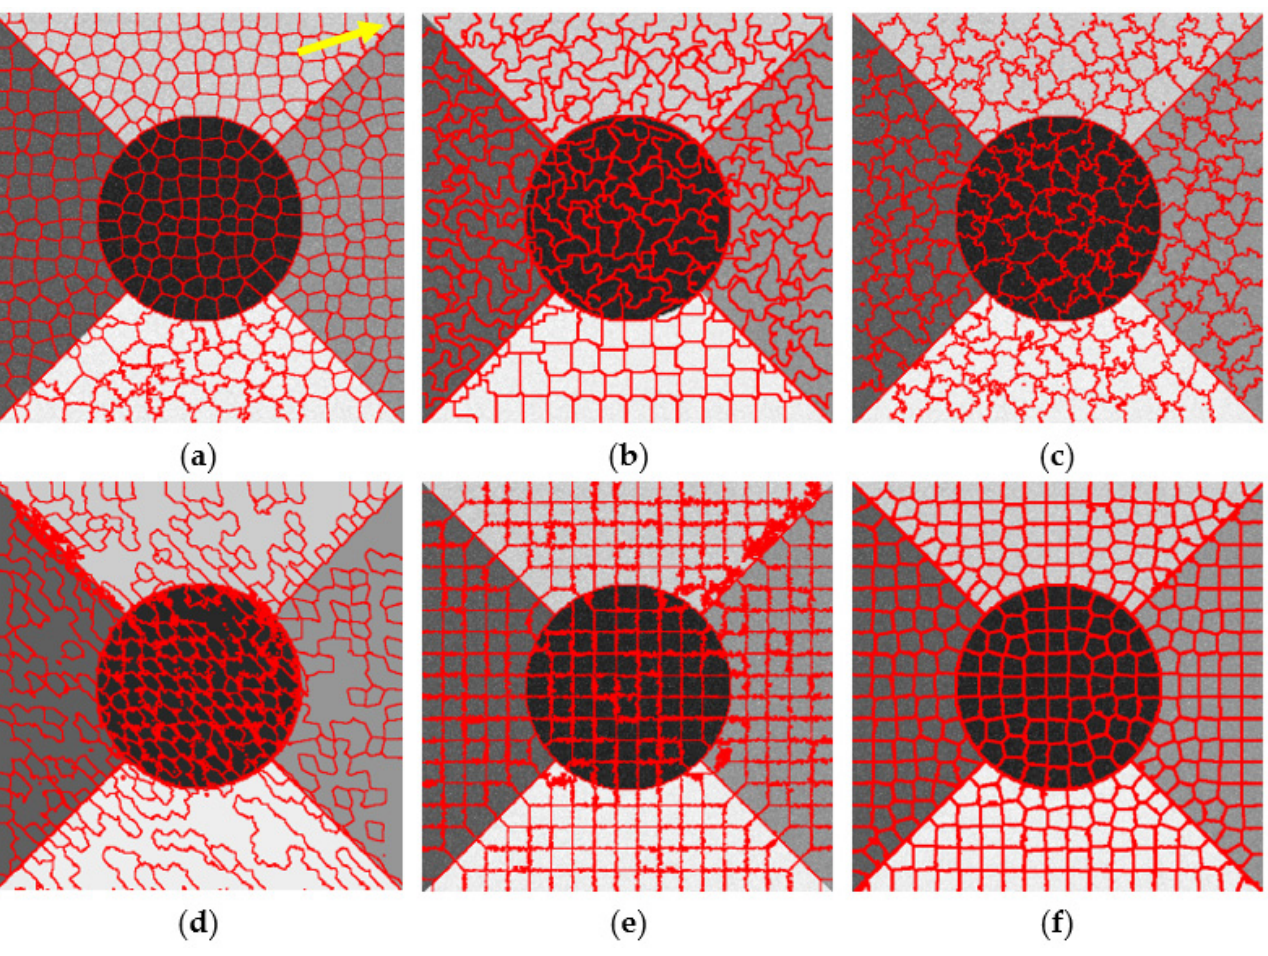
Figure 17. Superpixel generation results for the SAR image SI 3 . The edge of the position indicated by the yellow arrow cannot be detected. ( a ) SLIC, ( b ) SNIC, ( c ) SEEDS, ( d ) SPAMP, ( e ) CAS, and ( f ) EDTRS.